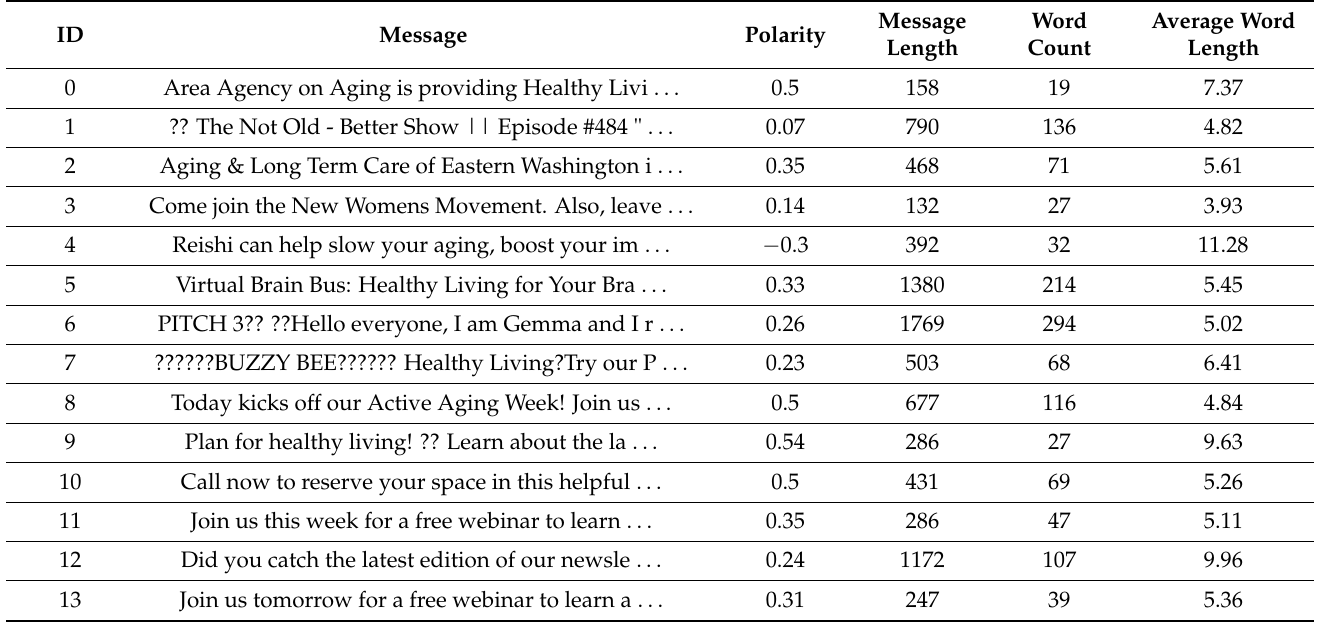
Table 2. Summary of descriptive analysis of messages. Examples of messages, sentiment polarity, message length, word length and average word length.